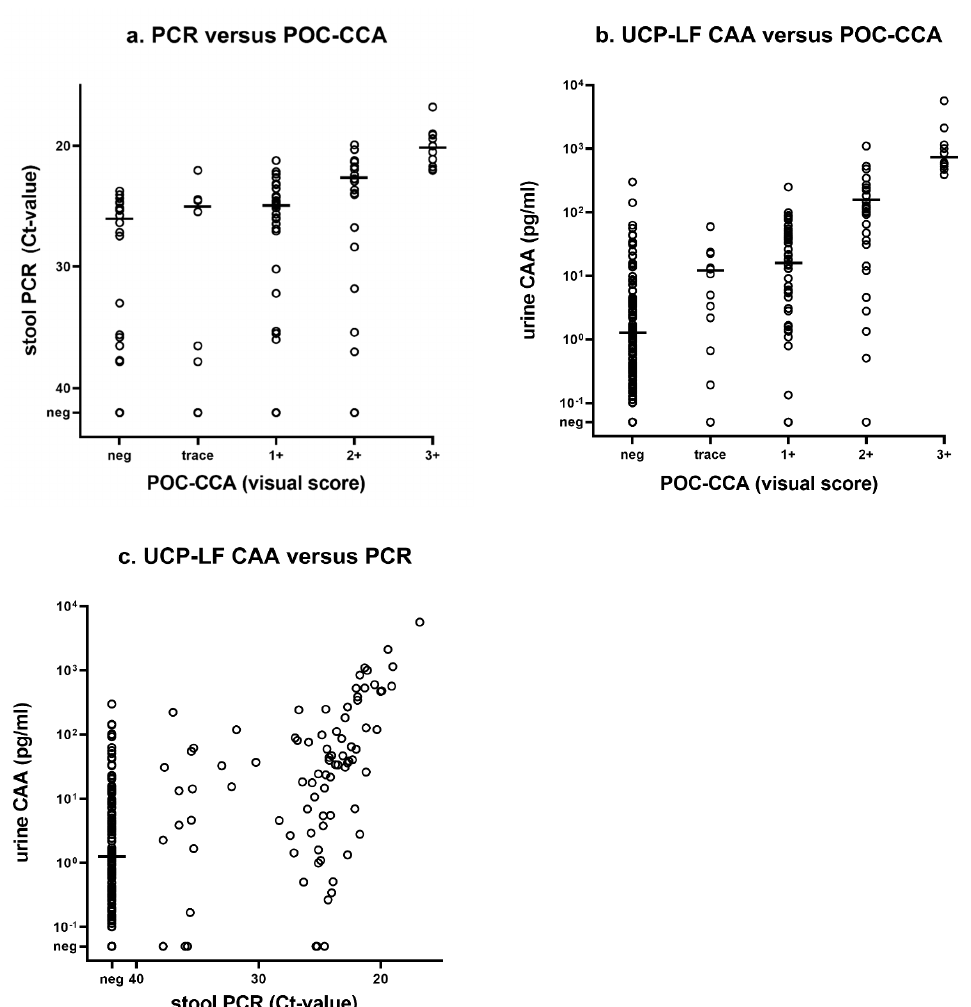
Figure 4. Correlation between polymerase chain reaction (PCR) in stool, point-of-care circulating cathodic antigen (POC-CCA), and the up-converting particle, lateral flow circulating anodic antigen (UCP-LF CAA) urine test: ( a ) PCR versus POC-CCA, ( b ) UCP-LF CAA versus POC-CCA, and ( c ) UCP-LF CAA versus PCR. Horizontal lines indicate the median Ct-value ( a ) or the median CAA concentration ( b , c ) of the positive tested samples.